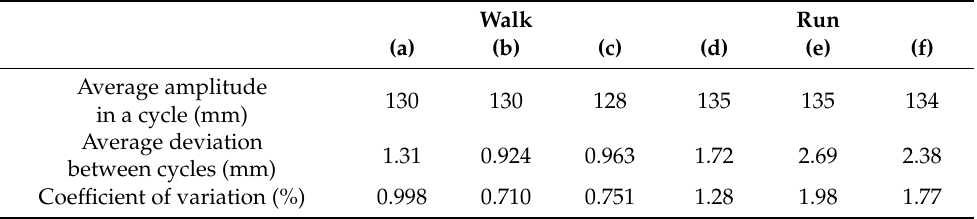
Table 1. Statistical analysis of circumference during walking and running with (a, d) conscious muscle co-contraction, (b, e) neutral, and (c, f) conscious muscle